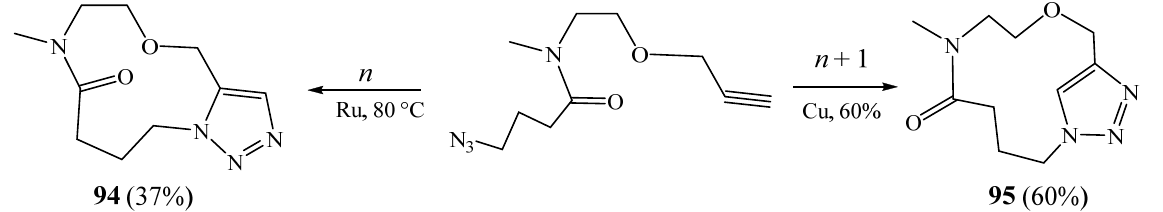
Figure 24. Effect of the catalyst nature on cyclisation. (Reprinted with permission from ref. [44]. Copyright 2009 American Chemical Societ).